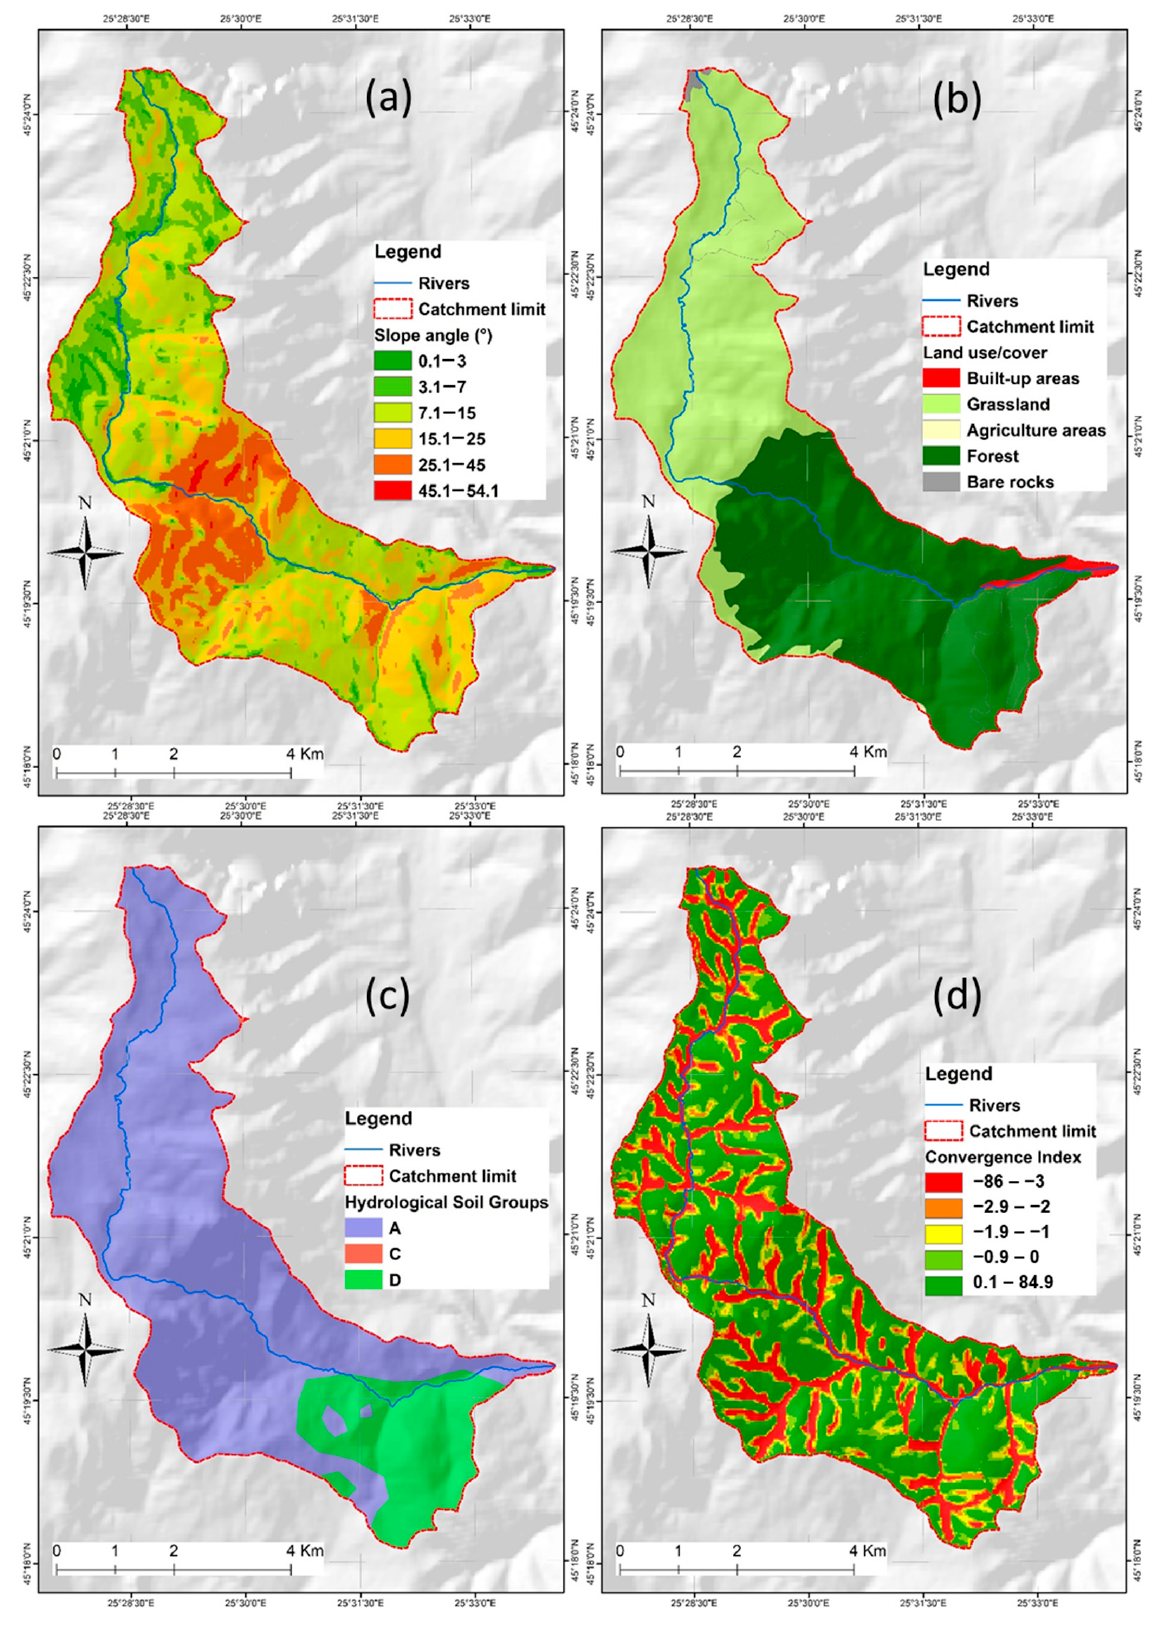
Figure 2. Flash-flood and flood predictors. ( a ) Slope; ( b ) Land use; ( c ) Hydrological Soil Group; ( d ) Convergence index.